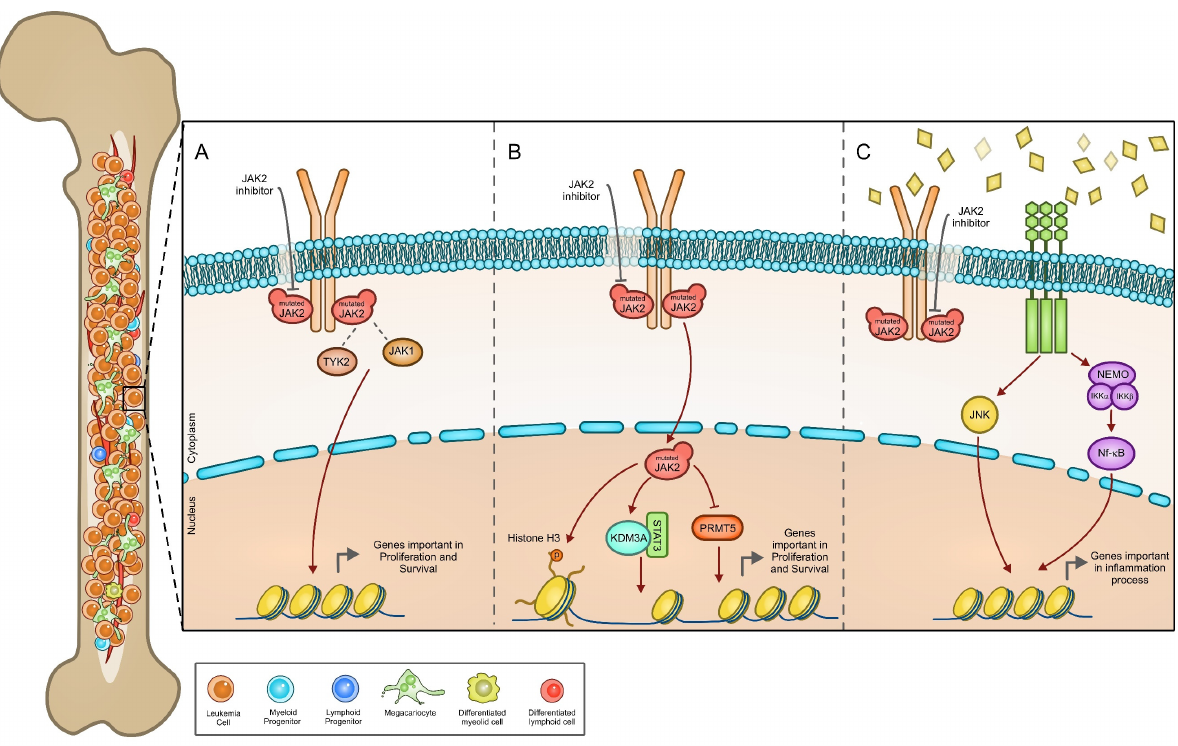
Figure 3. Altered molecular signaling pathways in resistant MPNs: ( A ) Mutant JAK2 can be activated through the formation of heterodimers with JAK1 or TYK2, thus sustaining STAT activation in the presence of JAK2 inhibitors. ( B ) JAK2 mutation can promote its translocation into the nucleus, where it phosphorylates different substrates (Histone H3, KDM3A, and PRMT5), modifying the epigenetic landscape of hematopoietic cells, thus promoting cancer cell proliferation and survival even in the presence of JAK2 inhibitors. ( C ) Besides JAK2 activation, aberrant cytokine release in MPNs